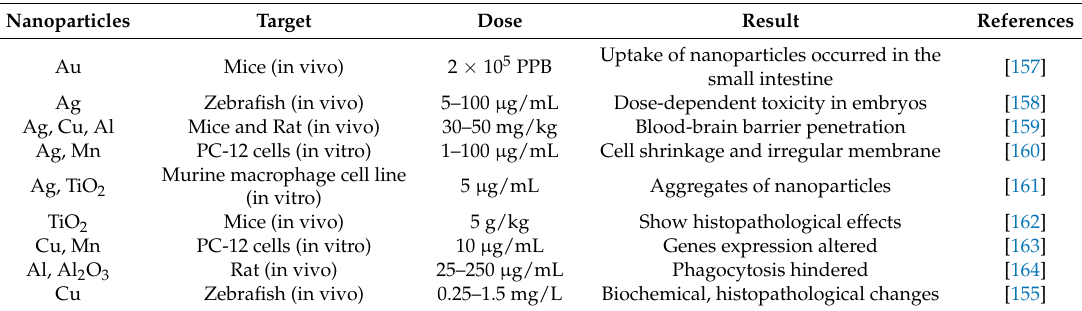
Table 1. Selected comparative toxicity